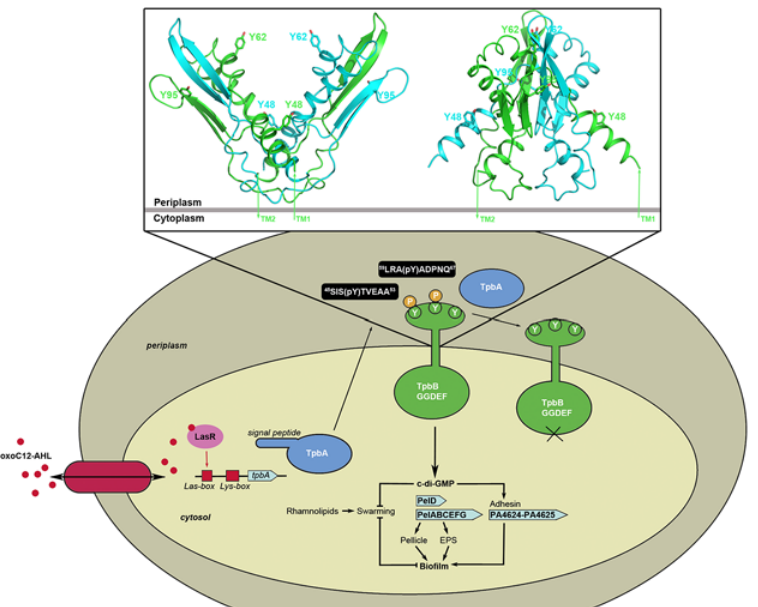
Fig 6. Schematic showing the regulation of biofilm formation in P . aeruginosa by TpbA (adapted from Ueda and Wood, 2009). Inset is an atomic model of the periplasmic LapD-like domain of TpbB showing the putative locations of the three tyrosine residues: Tyr48, Tyr62 and Tyr95. The LapD-like domain of TpbB is predicted to form a domain-swapped dimer, with the monomers coloured green and cyan. The model of the TpbB LapD-like domain was generated by Swiss-Model (http://swissmodel.expasy.org) using the Pseudomonas fluorescens LapD structure (PDB ID: 3PJV) as a